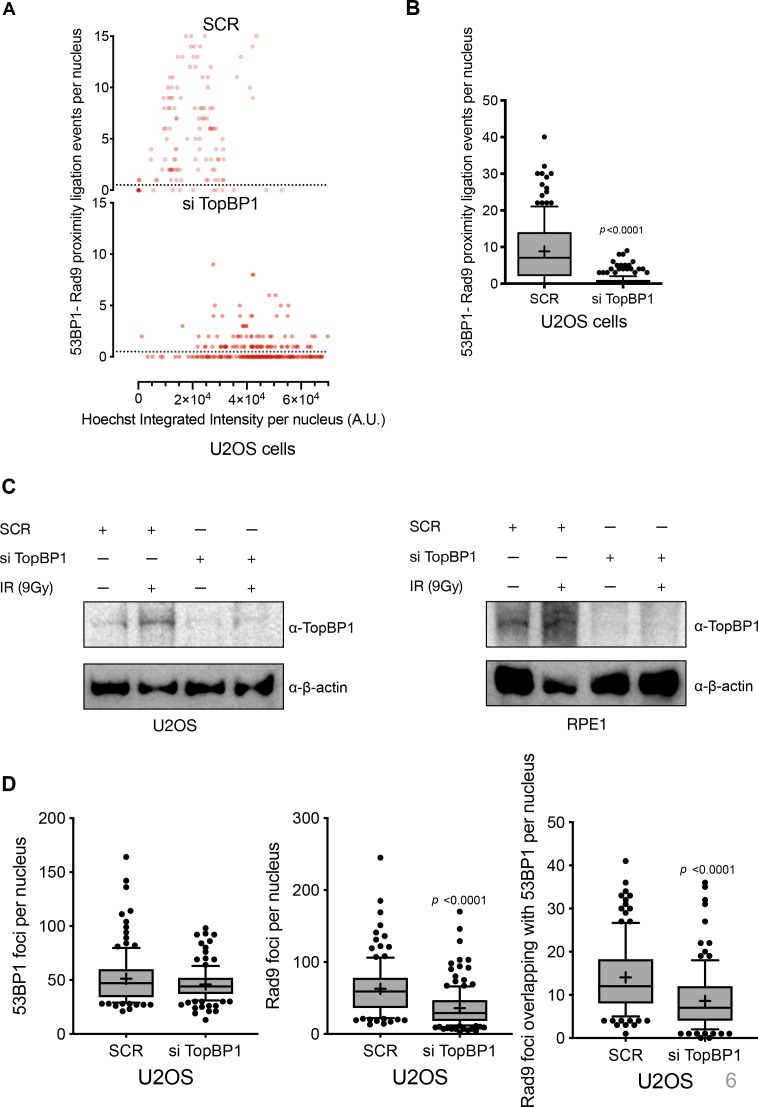
RAD9 - 53BP1 Proximity Ligation Assay in U2OS Cells.(A) Scatter plot of PLA events per nucleus for RAD9 – 53BP1 proximity as a function of nuclear Hoechst signal for irradiated U2OS cells in the presence of either a control scrambled siRNA (top) or an siRNA directed against TOPBP1 (bottom). The PLA signal in the control is predominantly seen in G1 cells (lower Hoechst staining). (B) Statistical analysis of PLA events in A., showing a very significant decrease in PLA signal between 53BP1 and RAD9 when TOPBP1 is knocked down compared to the control siRNA treated cells. More than 150 nuclei were counted per case. Median, mean (+), 10–90 percentiles and outliers are represented in boxplots. p values for the irradiated versus non-irradiated cells were calculated by a Mann-Whitney test. (C) Western blots demonstrating depletion of TOPBP1 protein in U2OS and RPE1 cells treated with siRNA targeted to TOPBP1. (D) Analysis of 53BP1 (left) and RAD9 (centre) foci counts per nucleus in the presence of siRNA knockdown of TOPBP1, and a non-targeting scrambled siRNA control. No significant difference in 53BP1 focus formation is seen between the targeted and non-targeted siRNA treatments. RAD9 foci numbers are decreased in the presence of siTOPBP1, but still present. Consistent with the PLA data, co-localisation of those RAD9 foci with 53BP1 is diminished. More than 200 nuclei were counted per case. Median, mean (+), 10–90 percentiles and outliers are represented in boxplots. p values for the targeting versus scrtambled siRNA were calculated by a Mann-Whitney test.